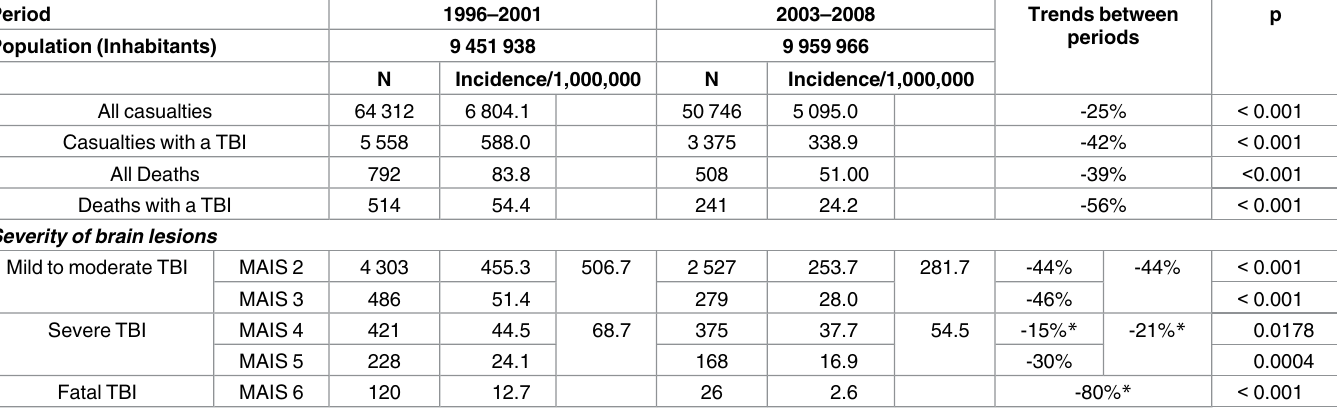
Table 1. Trends of figures, incidence and mortality rates of road crash trauma and RTC-related TBIs regarding the TBI-severityin the two observa- tion periods, before and after law enforcement in France. Period